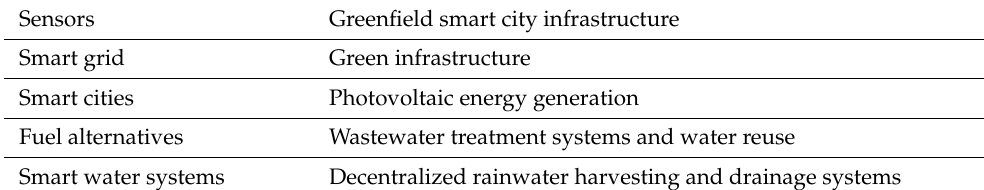
Table 6. Selection of the relevant megatrends.